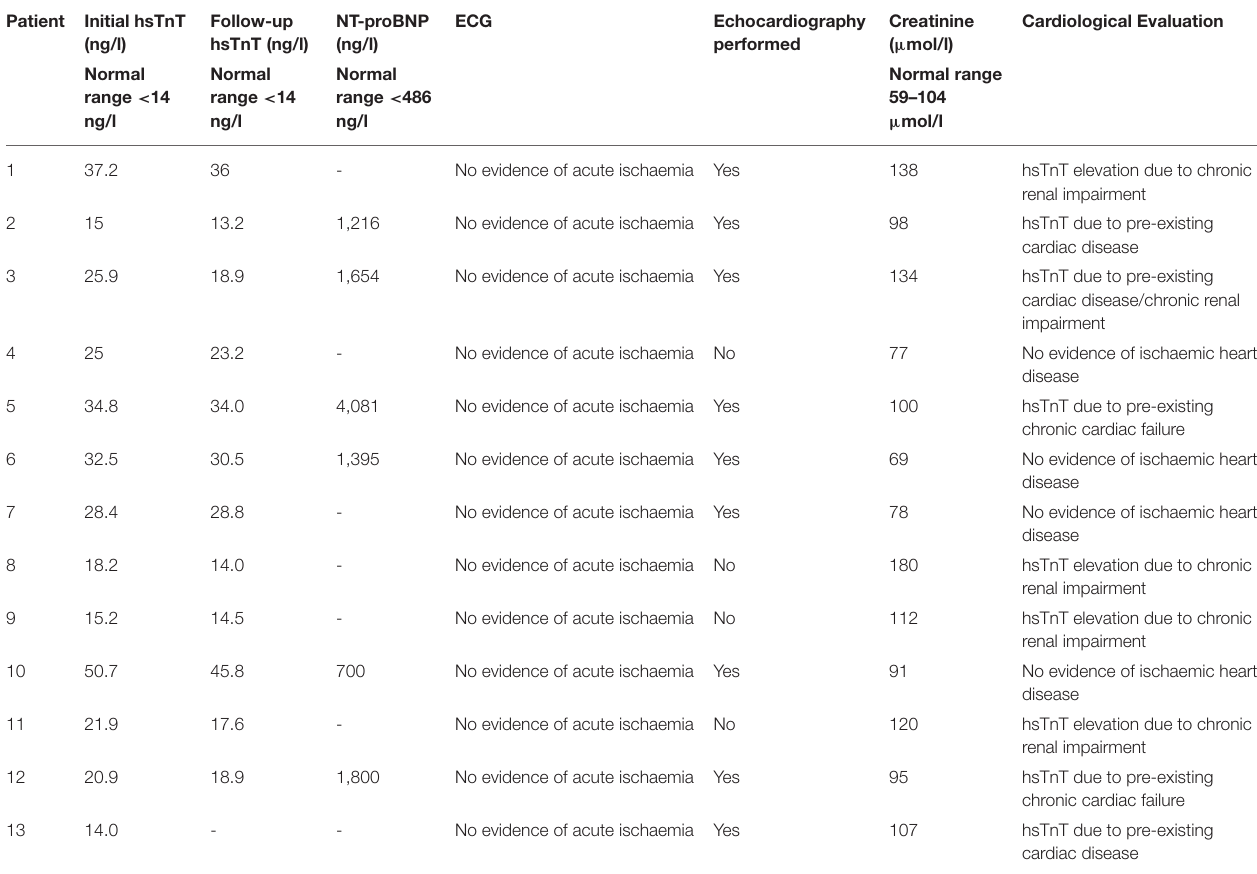
TABLE 3 | Cardiological assessment in patients with elevated hsTnT concentrations. Patient Initial hsTnT (ng/l)